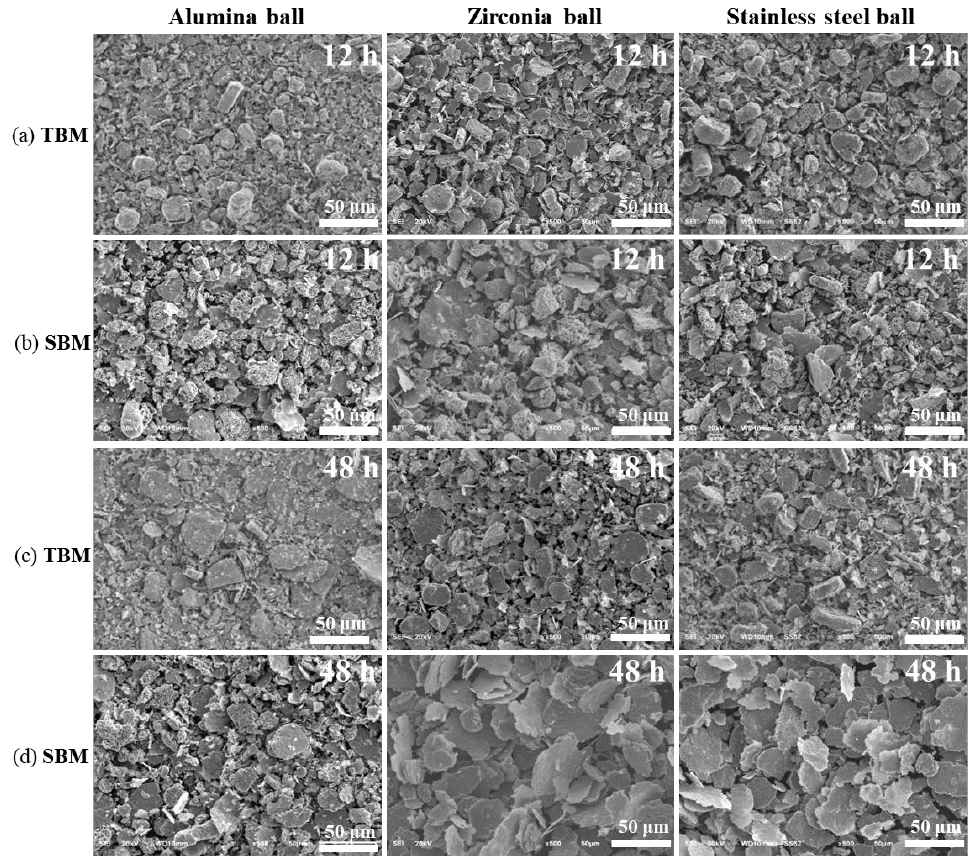
Figure 4. SEM images showing morphologies of Cu/CNT nanocomposites during exposure to different milling media ( a ) 12 h TBM, ( b ) 12 h SBM, ( c ) 48 h TBM, and ( d ) 48 h SBM at 100 rpm.